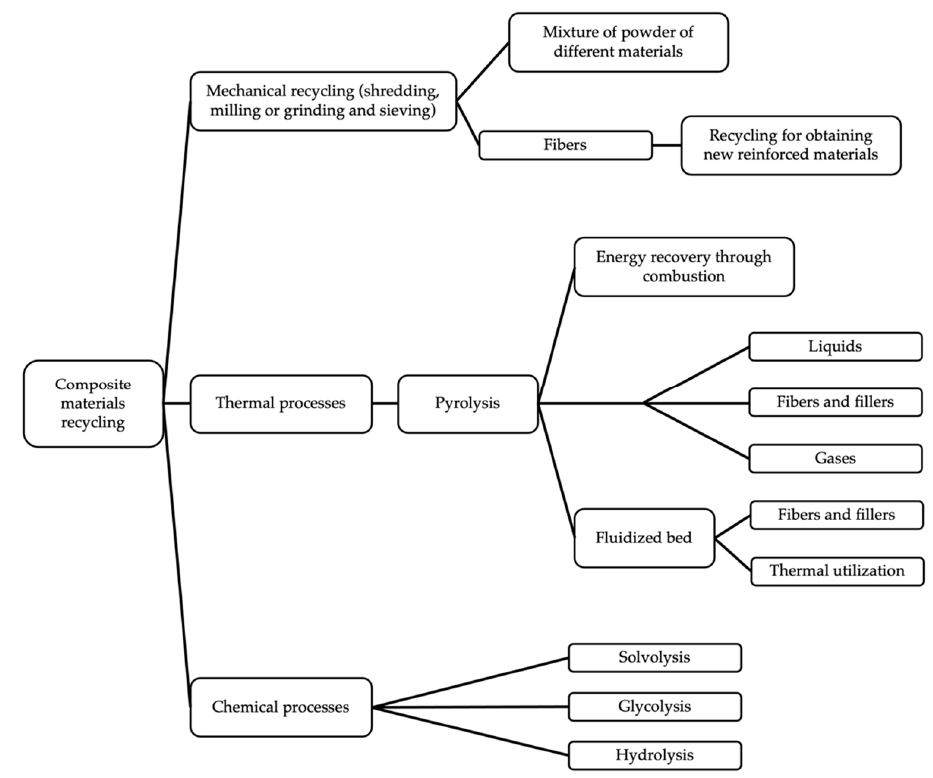
Figure 2. Composite materials recycling alternatives.